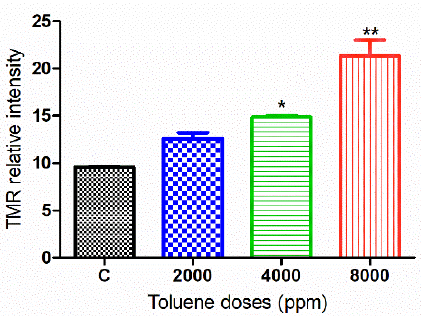
with Hoechst and TMR red. Ovaries from control ( A – C ), ovaries from females that were exposed to